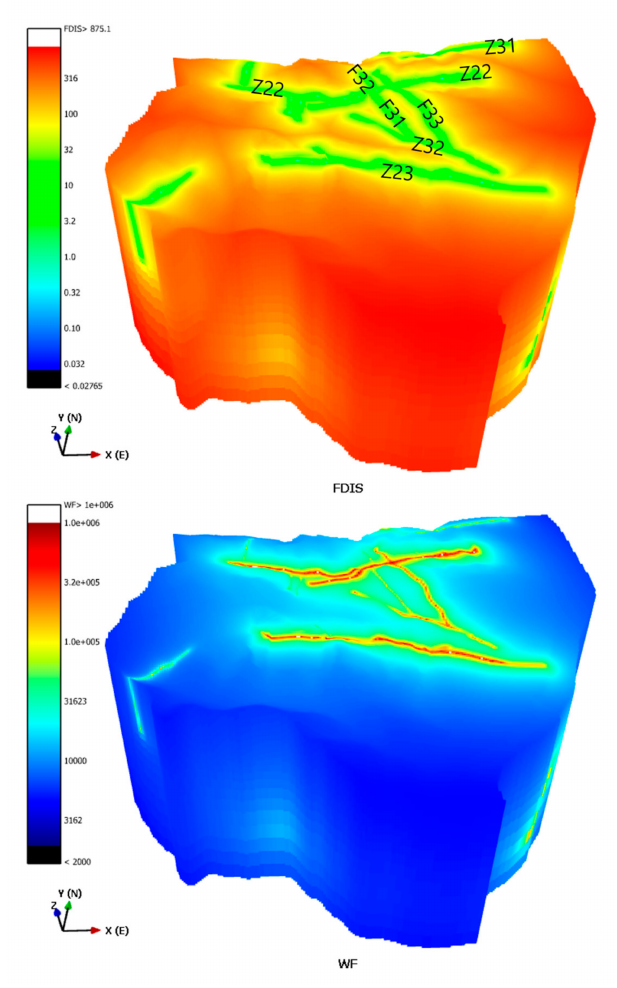
Figure 7. FDIS (minimum distance to fault) and WF (normalized inverse distance from the faults weighted by nearest fault